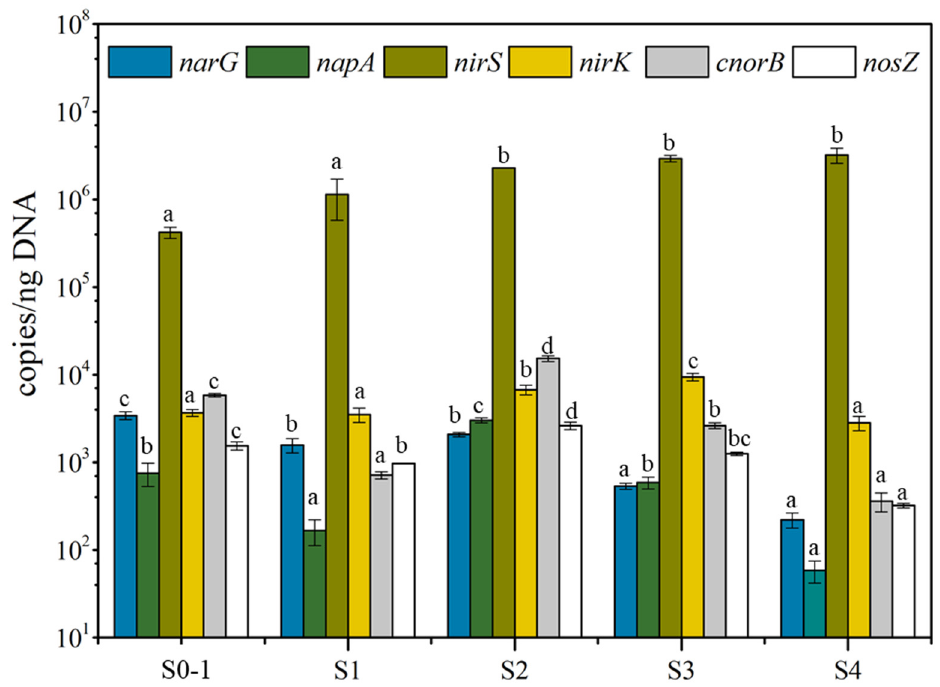
Figure 4. Relative abundances of six denitrification genes in biofilms in each stage. Different lower- case letters indicate significant differences among stages at p < 0.05.